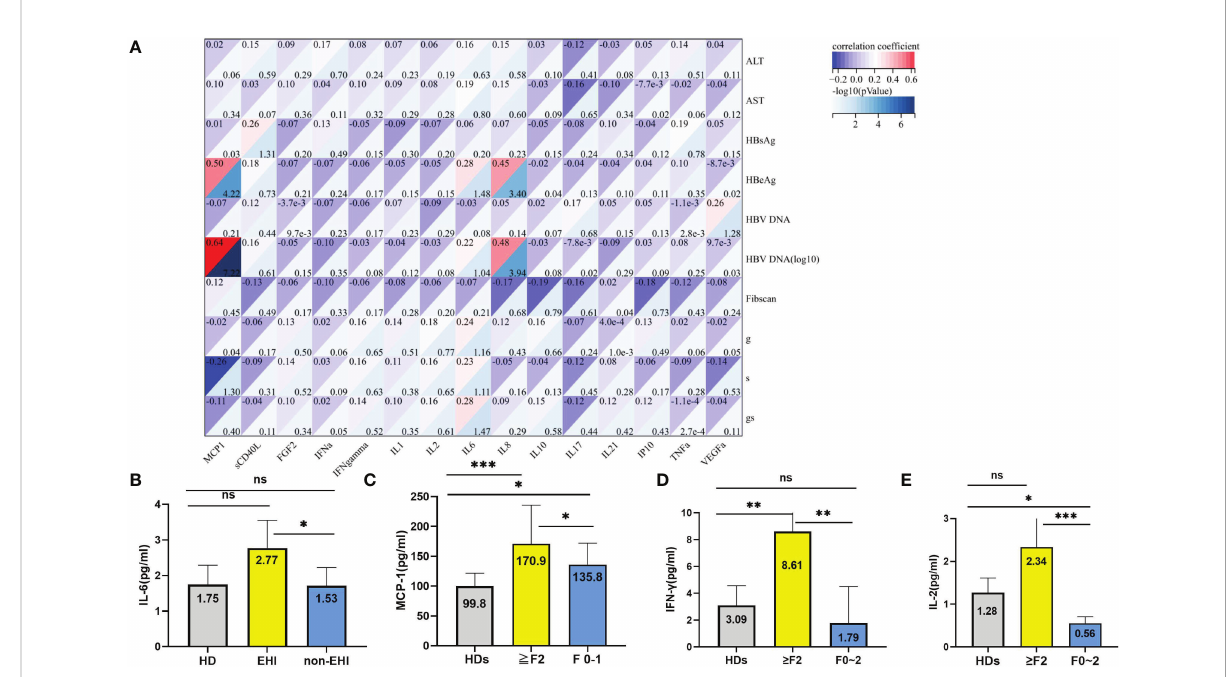
FIGURE 5 Relationship of the plasma cytokines with EHI. (A) Correlation of the cytokines with clinical characteristics and signi fi cant liver injury. (B) Comparison of the IL-6 levels in different groups. (C) Comparison of the MCP-1 levels in different groups. (D) Comparison of the IFN- g levels in different groups; (E) Comparison of the IL-2 levels in different groups. *p <0.05, **p <0.01, ***p <0.001; ns, not signi fi